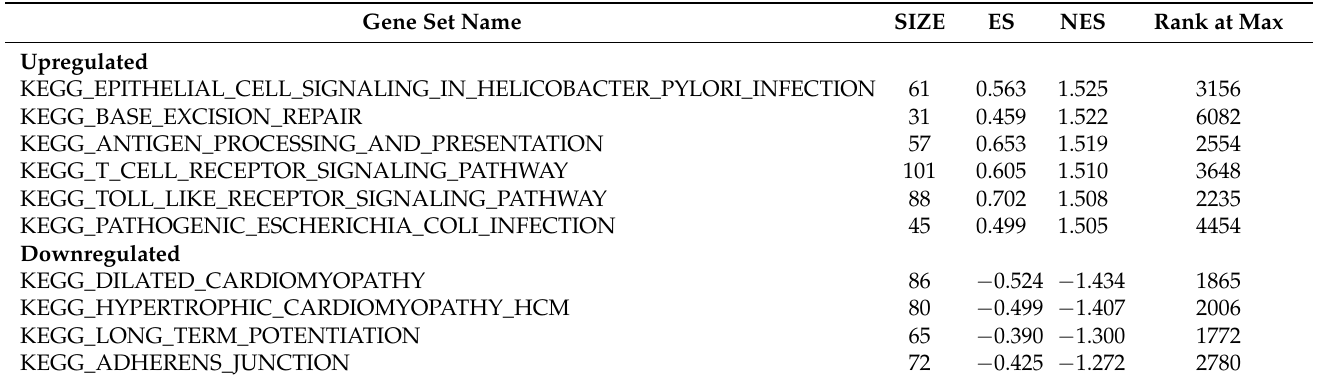
Table 2. Pathway enrichment analysis of DEGs in keloid using